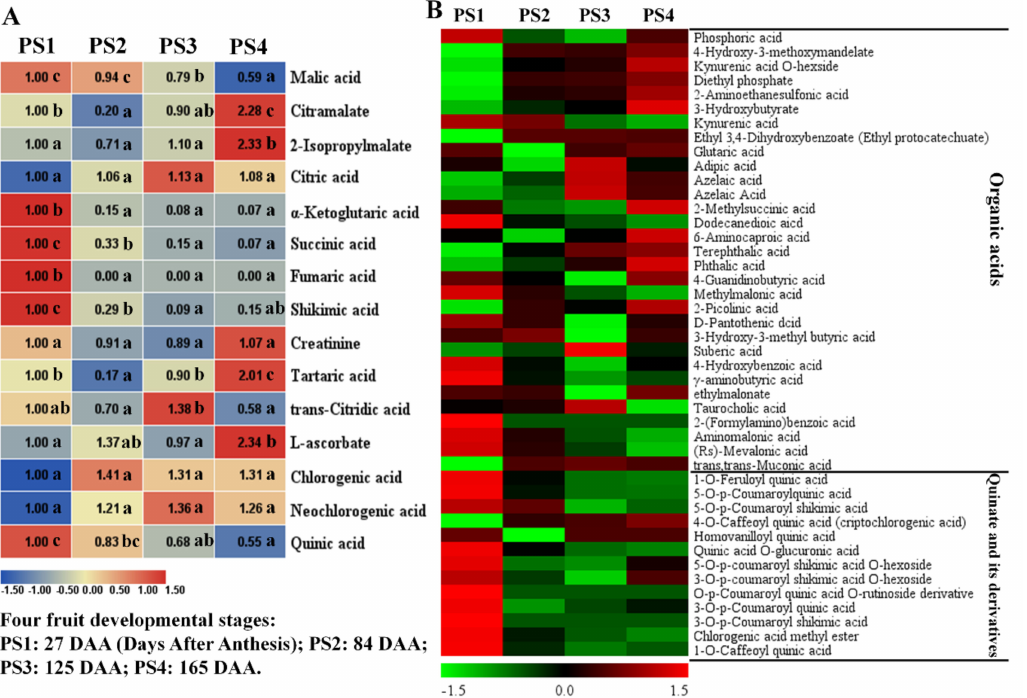
Figure 3. Changes of organic acids and quinate (and its derivatives) during four fruit developmental stages. ( A ) Heat map of 15 representative organic acids: the fold changes of each metabolite among these four stages were displayed in heat map which used the first stage of 27 Days After Anthesis (DAA) as the calibrator. PS1, 2, 3, and 4 represents four fruit developmental stages: 27, 84, 125, 165 Days After Anthesis (DAA), respectively. Significant analysis was performed by SPSS software based on Tukey’s test at p < 0.05 level and showed with lower cases a, b, and c in figure. Di ff erent letters indicate significant di ff erences between two samples. ( B ) Heat map of organic acids and quinate (and its derivatives): the colors indicate the proportional content of each identified metabolites as determined by the average peak response area with R scale normalization. Three independent replicates were performed for each